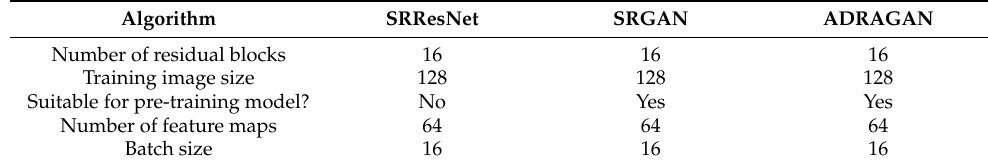
Table 4. Network parameters of each algorithm.